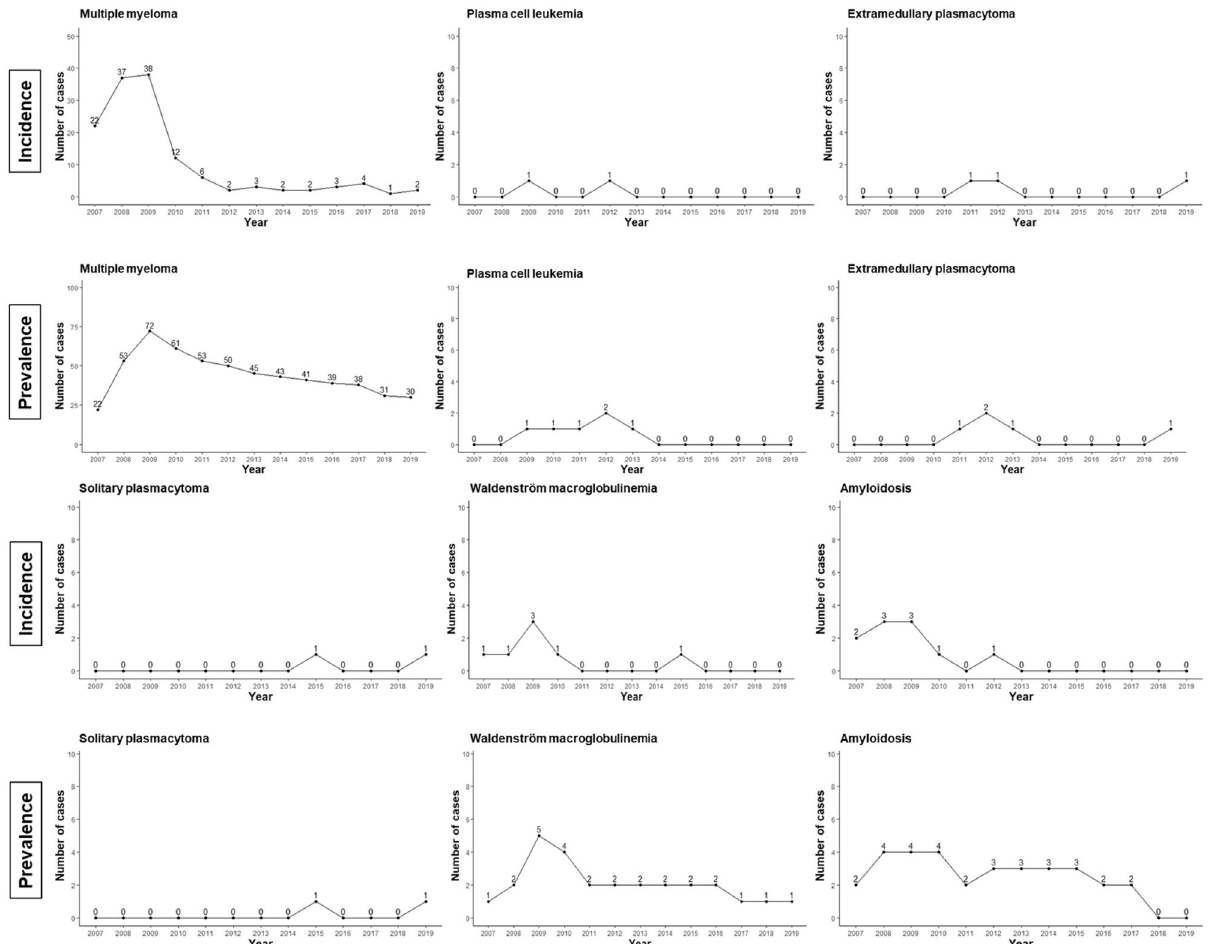
Figure 2. The occurrence patterns of disease progression during the follow-up period. The incidence of disease progression was presented as the number of new patients in the year in patients with MGUS in this study. The prevalence was presented as the number of total patients in the year in patients with MGUS in this